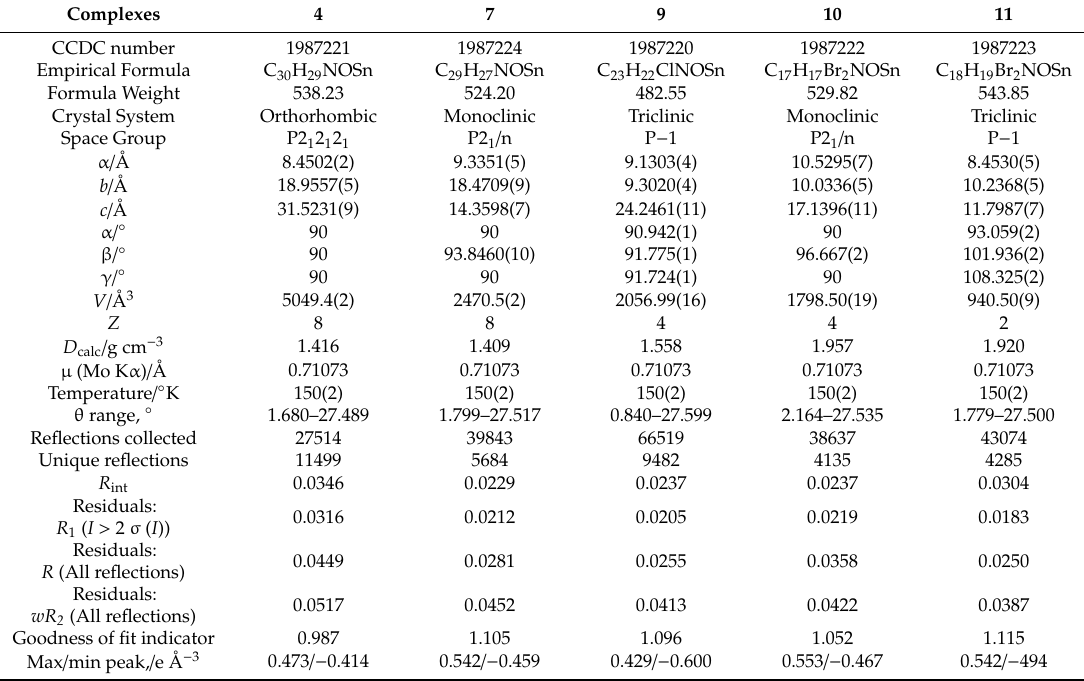
Table 4. Crystal data and structure refinement of complexes 4 , 7 , 9 – 11